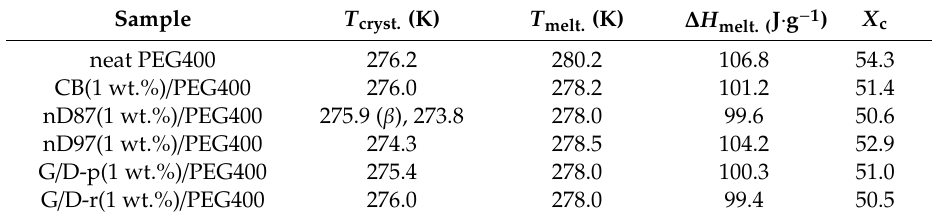
Figure 2. ( a ) Cooling and ( b ) heating differential scanning calorimetry (DSC) curves obtained at 0.5 K·min − 1 for the neat PEG400 and the nanofluids prepared at 1 wt.% nanoparticle loadings. Table 2. Crystallizing, T cryst. , and melting, T melt. , temperatures; latent heat of fusion, ∆ H melt. , and crystallinity degrees, X c , obtained for neat PEG400 and dispersions prepared at 1 wt.% nanoparticle concentrations from DSC scans at 0.5 K · min − 1